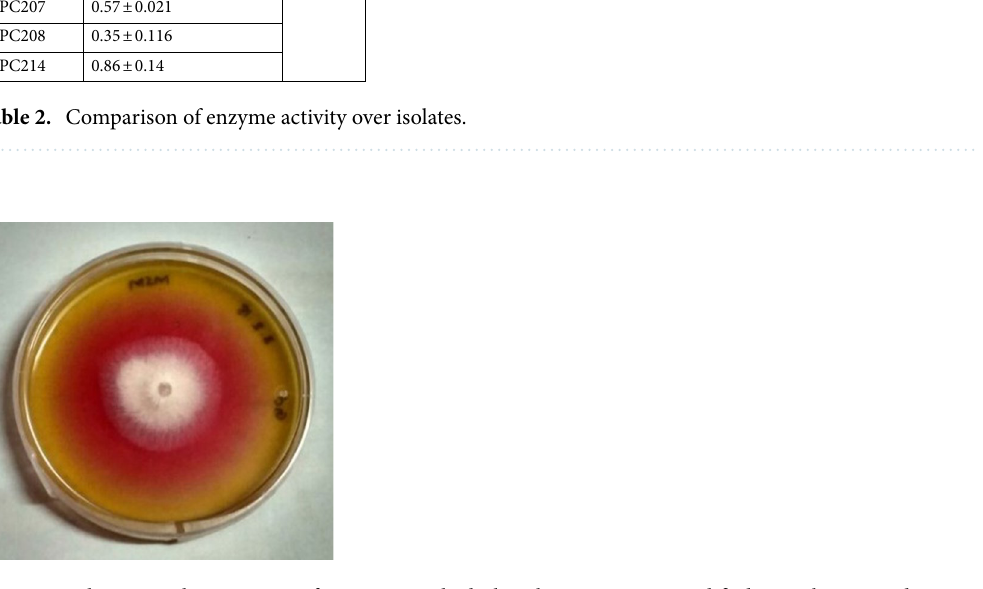
Figure 1. Plate assay showing zone of l-asparagine hydrolysis by GPC191 on modified Czapek Dox medium supplemented with phenol